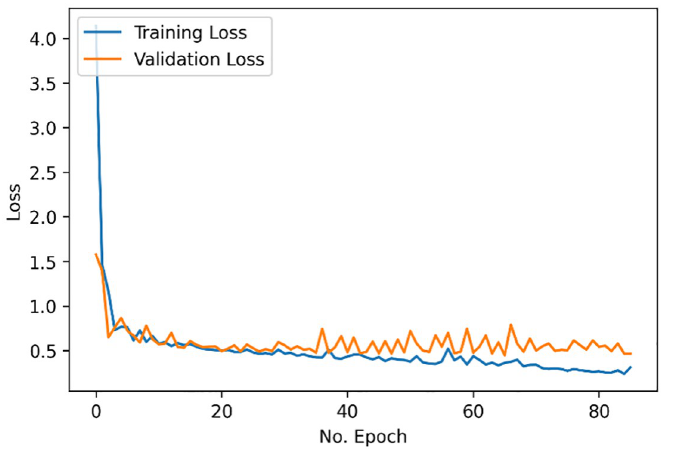
Fig 3. Bi-LSTM-A training and validation